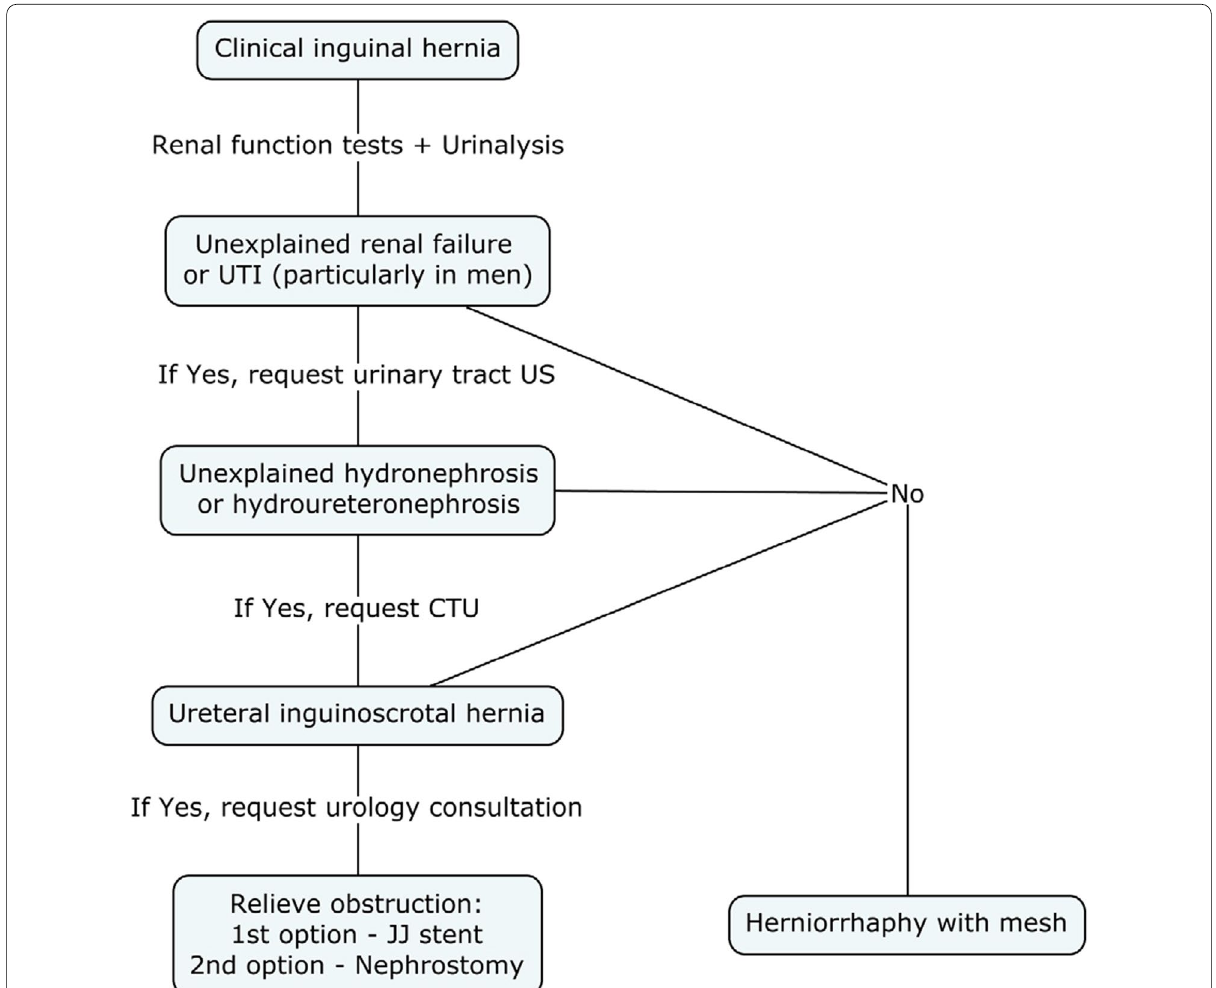
Fig. 6 Algorithm for ruling out and diagnosing ureteral inguinoscrotal hernia, adapted from Yahya et al. [1]. UTI urinary tract infection, US ultrasound, CTU computed tomography